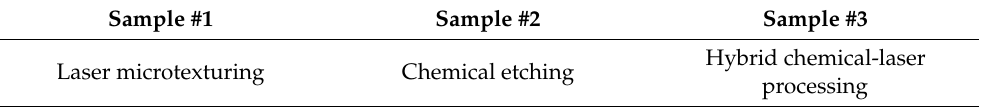
Table 1. The numbers of samples and corresponding processing